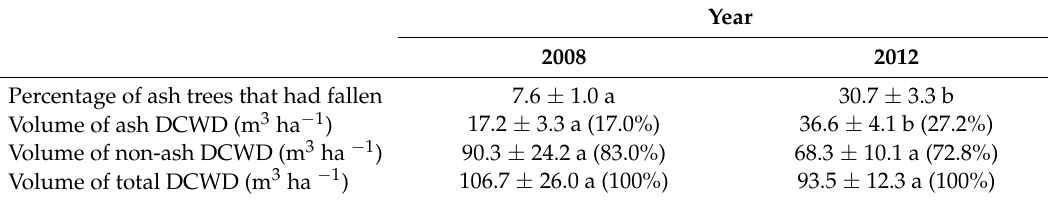
Table 2. Patterns of downed coarse woody debris (DCWD) sampled in 2008 and 2012 in 16 forest stands in the Upper Huron River watershed in southeastern Michigan, USA for the percentage of ash trees that had fallen, volume of ash DCWD (m 3 ha − 1 ), volume of non-ash DCWD (m 3 ha − 1 ), and volume of total (ash and non-ash) DCWD (m 3 ha − 1 ) by year (2008 and 2012). Data are expressed as mean ± SE, with percentage of total DCWD in parentheses. Comparisons were made across years, with means followed by different letters being significantly different at α =